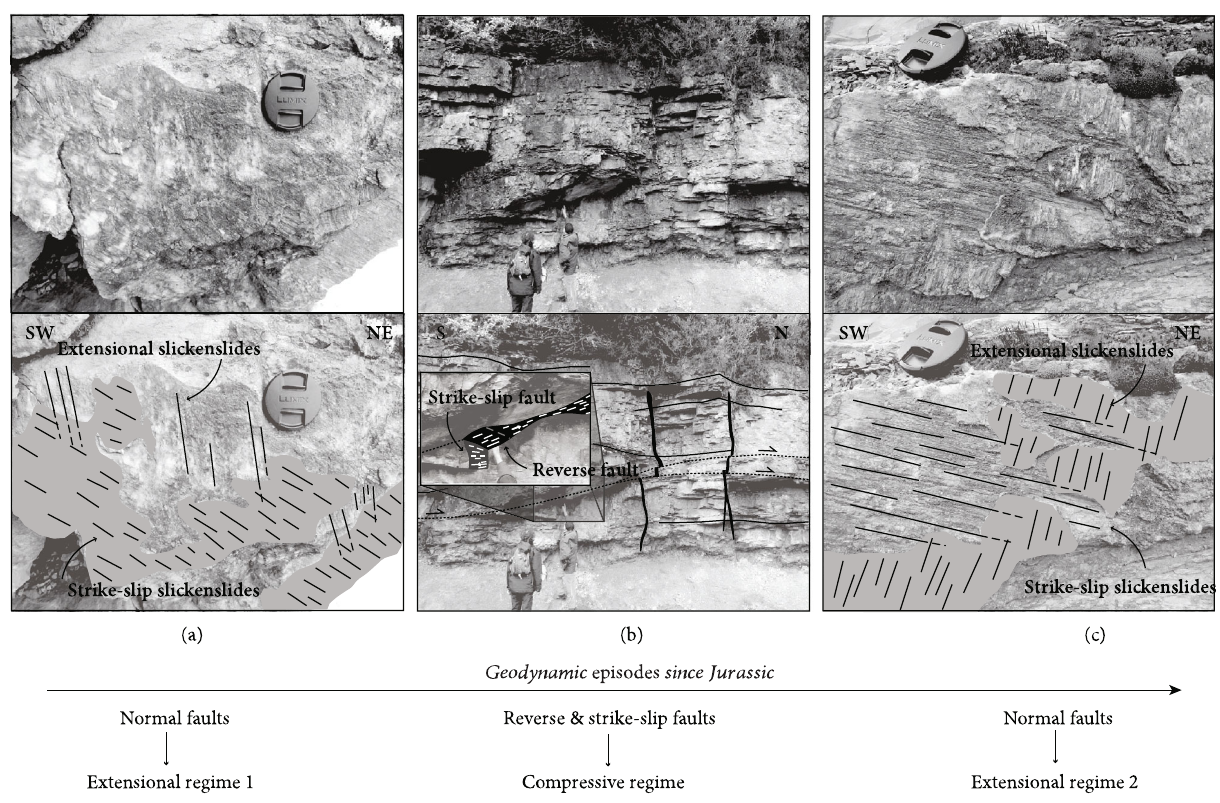
Figure 6: Tectonic structures showing relative chronology between deformation episodes. (a) This illustration shows an extensional regime intersected by a strike-slip regime on a fault mirror. (b) A reverse fault observed at the scale of the outcrop shifts a dextral strike-slip fault plane. (c) Slickenside normal fault-related calcites overlapped by strike-slip slickenside